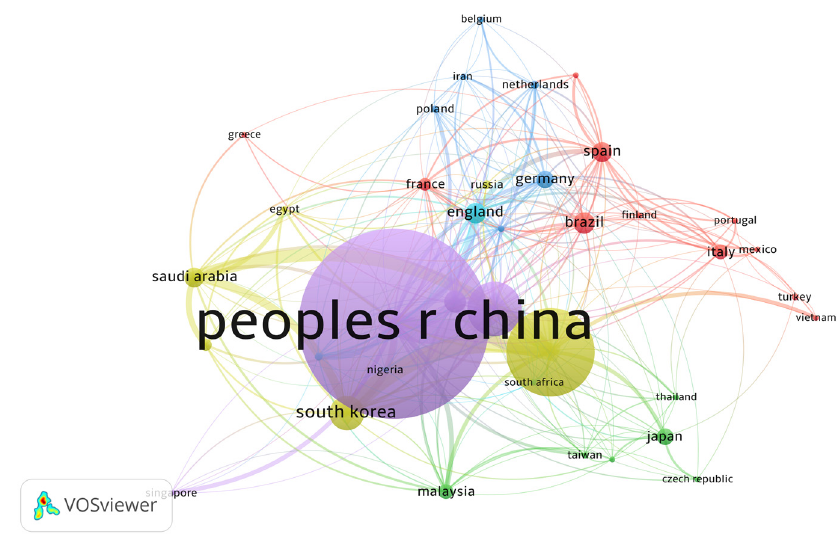
Figure 3. Leading countries in publications of PS